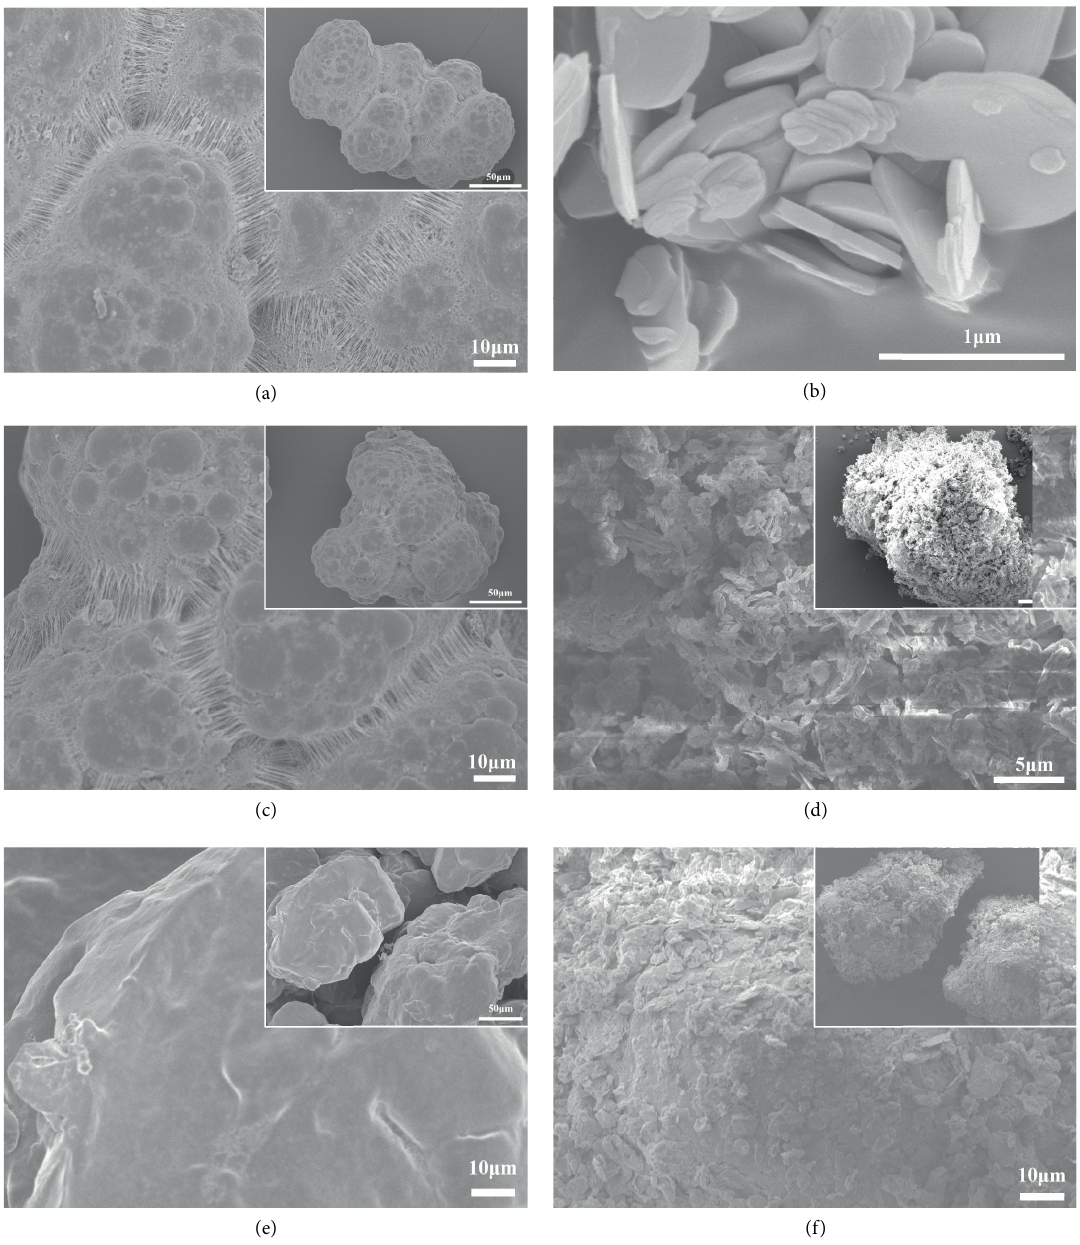
Figure 1: SEM of (a) UMMWPE nascent powder; (b) BN; (c) 0 wt% and (d) 40 wt% BN coated on UHMWPE particles by solvent mixing before hot pressing, (e) 0 wt% and BN (f) 40 wt% BN coated on UHMWPE particles by melt mixing before hot